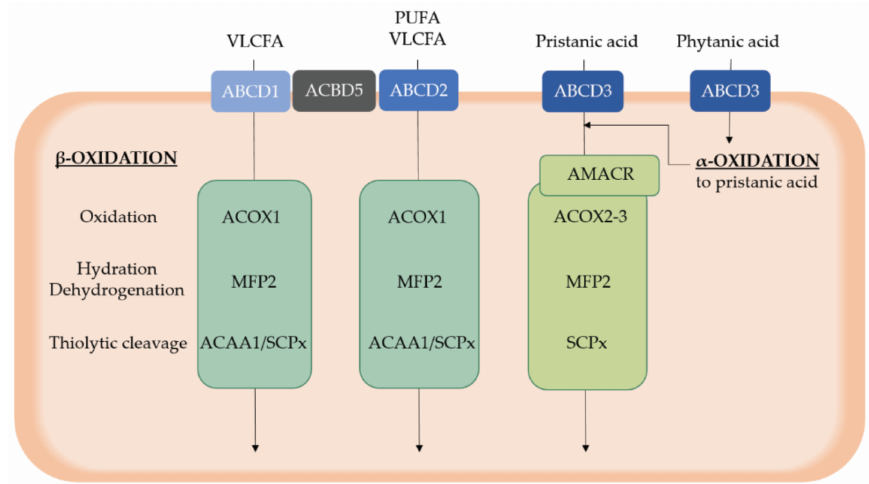
Figure 2. Overview of peroxisomal α - and β -oxidation of substrates relevant for retinal homeostasis. Phytanic acid is catabolized via peroxisomal α -oxidation, resulting in the formation of the 2-methyl branched chain fatty acid pristanic acid that subsequently undergoes peroxisomal β -oxidation similar to other substrates, including VLCFAs and PUFAs. After activation to a CoA ester, substrates are translocated in peroxisomes via three ABCD transporters, which exert a differential, although not absolute, substrate specificity. Peroxisomal β -oxidation occurs in four steps whereby the second and third step are catalyzed by a multifunctional protein. Of note, pristanic acid first needs to be converted into the S-configuration by AMACR. Furthermore, ACBD5 is assumed to present VLCFAs to the ABCD transporters, besides its role in the tethering of peroxisomes to the endoplasmic retic- ulum. ABCD, ATP binding cassette subfamily D; ACAA1, acetyl-CoA acyltransferase 1; ACBD5, Acyl-CoA binding domain containing protein 5; ACOX, acyl-CoA oxidase; D/THCA, di- and trihy- droxycholestanoic acid; MFP, multifunctional protein; PUFAs, polyunsaturated fatty acids; SCPx, sterol carrier protein x; VLCFAs, very long chain fatty